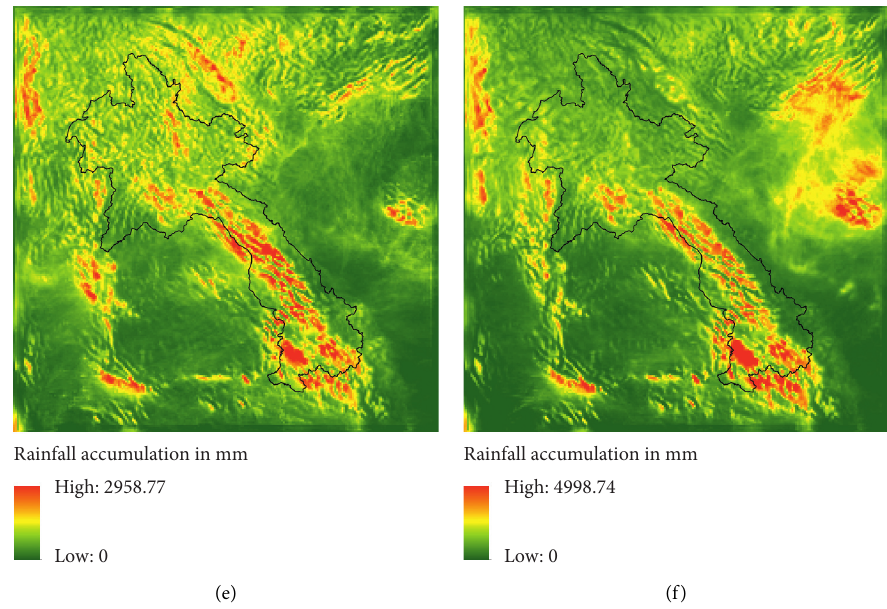
Figure 6: Rainfall accumulation for the wet season. (a) GSMaP 2017, (b) GSMaP 2018, (c) WRF ensemble E with BMJ 2017, (d) WRF ensemble E with BMJ 2018, (e) 2017 WRF ensemble A with KF, and (f) 2018 WRF ensemble A with KF